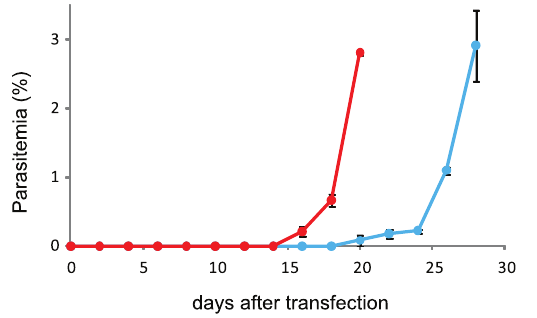
Figure 3. The Growth of the Transgenic Parasite after Transfection with pFCEN. The transfection of the parasite with pFCEN (red line) and pCon (blue line) were performed as described in the Materials and Methods. After 48 hours, the drug screening of the transgenic parasites was initiated by supplementing the culture medium with pyrimethamine. The parasitemia of the transgenic parasites was monitored every 48 hours after transfection. The transfection experiments for each plasmid were performed in triplicate.